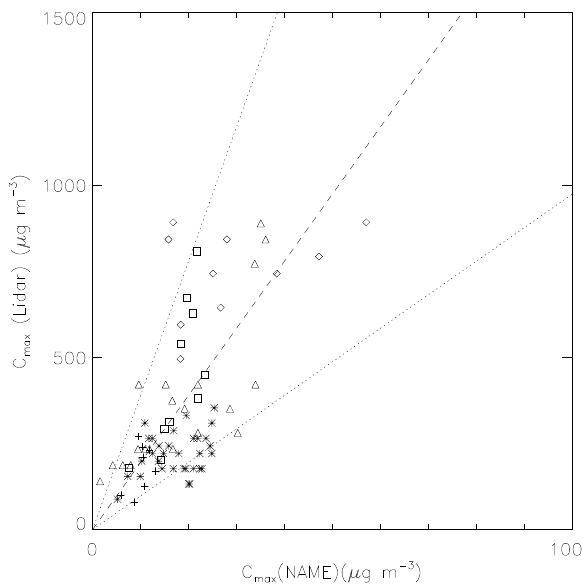
Fig. 12. Comparison between maximum concentrations from the NAME simulations and estimated from the FAAM lidar. The NAME concentrations have been scaled by the distal fine ash fraction determined from the CIML. The symbols are the same as Fig. 10. The dashed line shows y = 1 . 95 x , the dotted lines have gradients that are twice and half those of the dashed